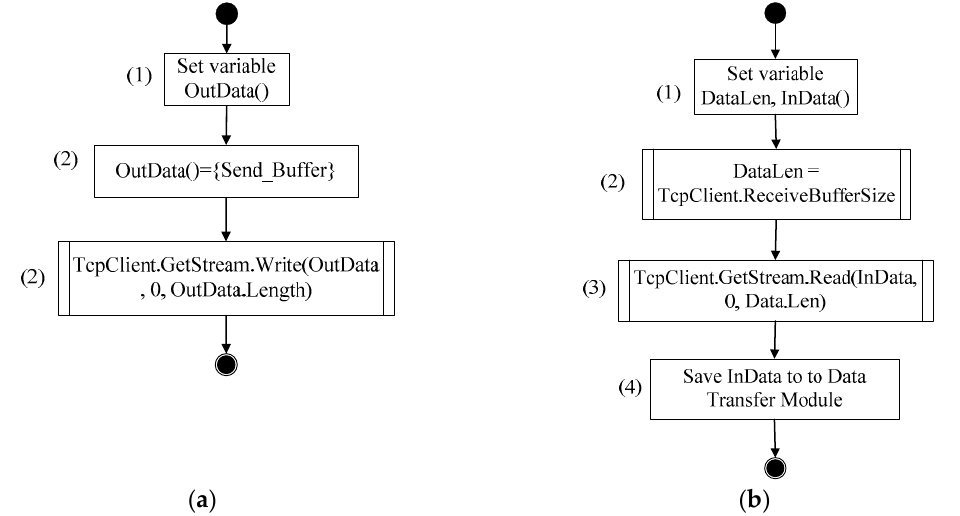
Figure 5. ( a ) Send process; ( b ) receive process in Ethernet communication.